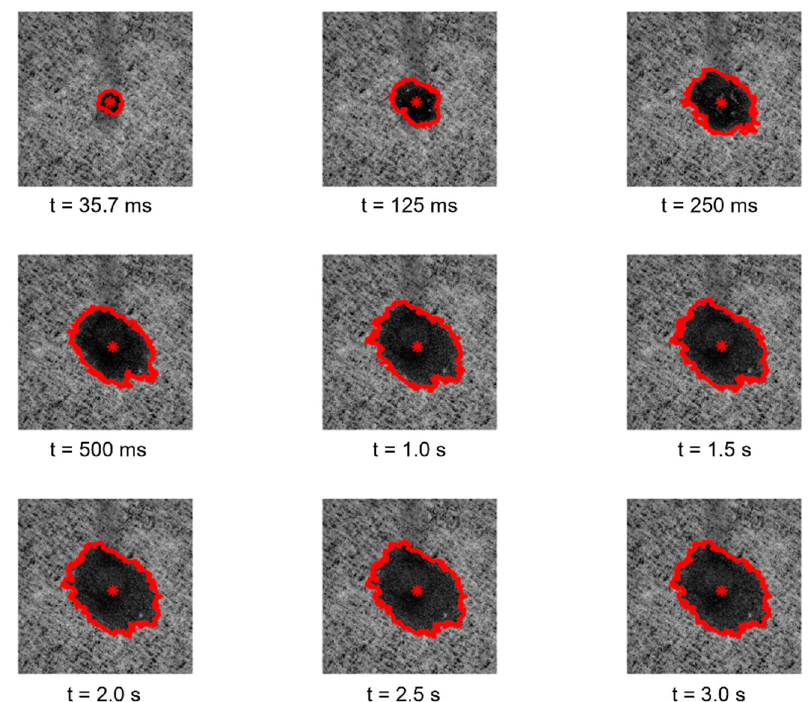
Figure 13. Spreading dynamics of a liquid droplet from t = 35.7 ms to 3 s for the tissue-paper sample Bm sd .